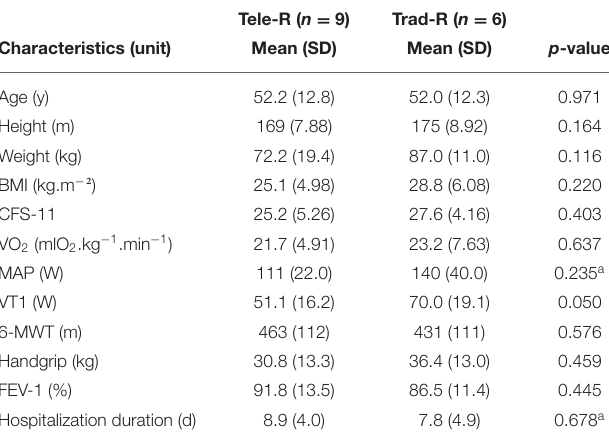
TABLE 2 | Characteristics of the study